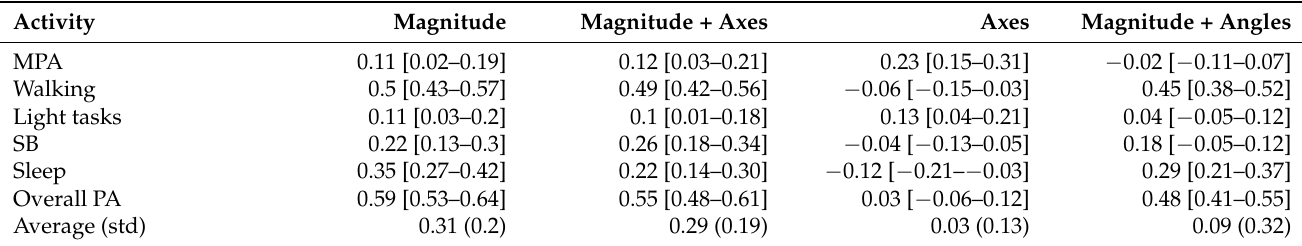
Table 4. Effect of different features on the correlation between time spent in activities as estimated by our unsupervised HSMM model and by the supervised model of Willetts et al. [7]. Data presented as Pearson’s correlation coefficients and 95% confidence intervals, unless otherwise stated.